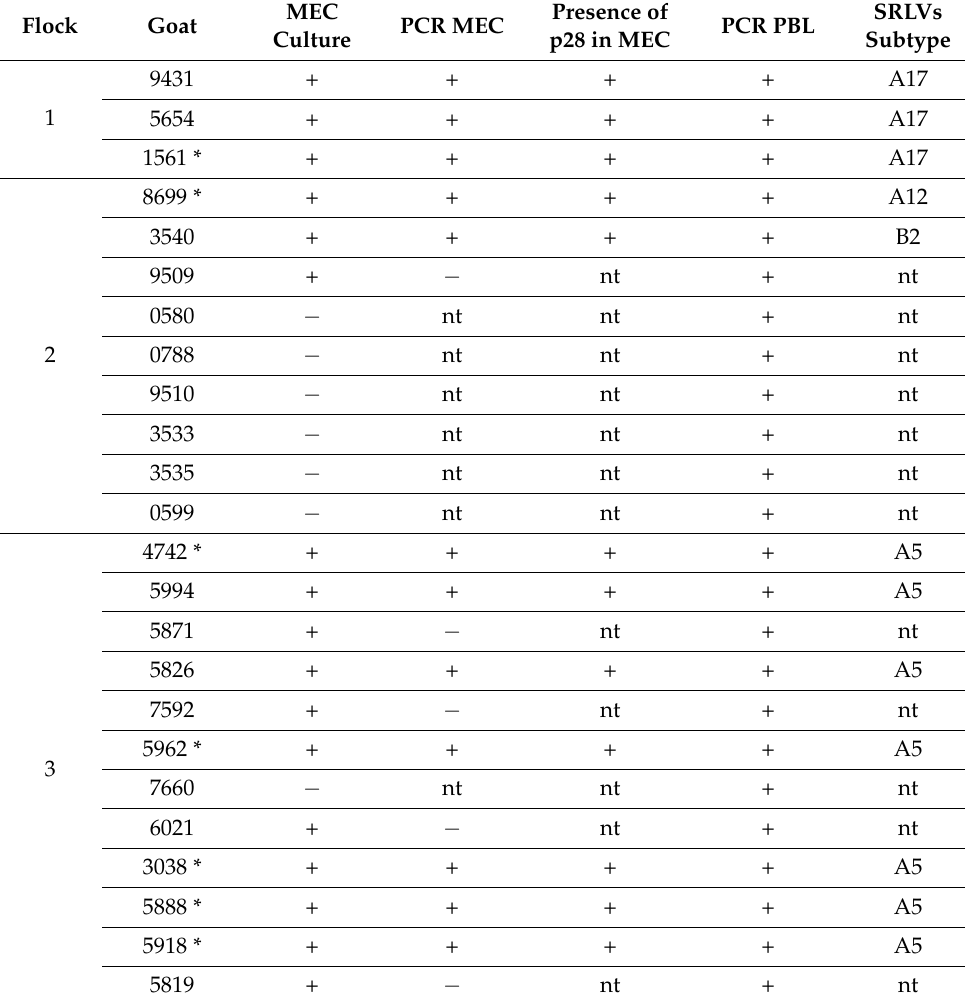
Table 1. Characteristic of samples examined in this study. MEC Flock Goat